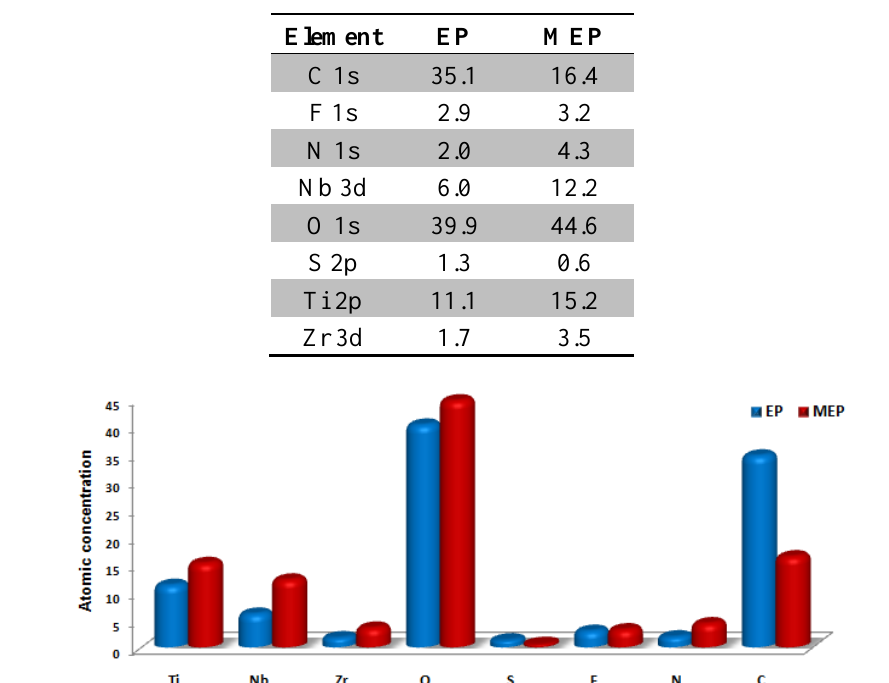
Table 2. Atomic concentration of detected elements in the passive layer of the TNZ alloy surface after EP and MEP on the basis of high resolution XPS spectra.